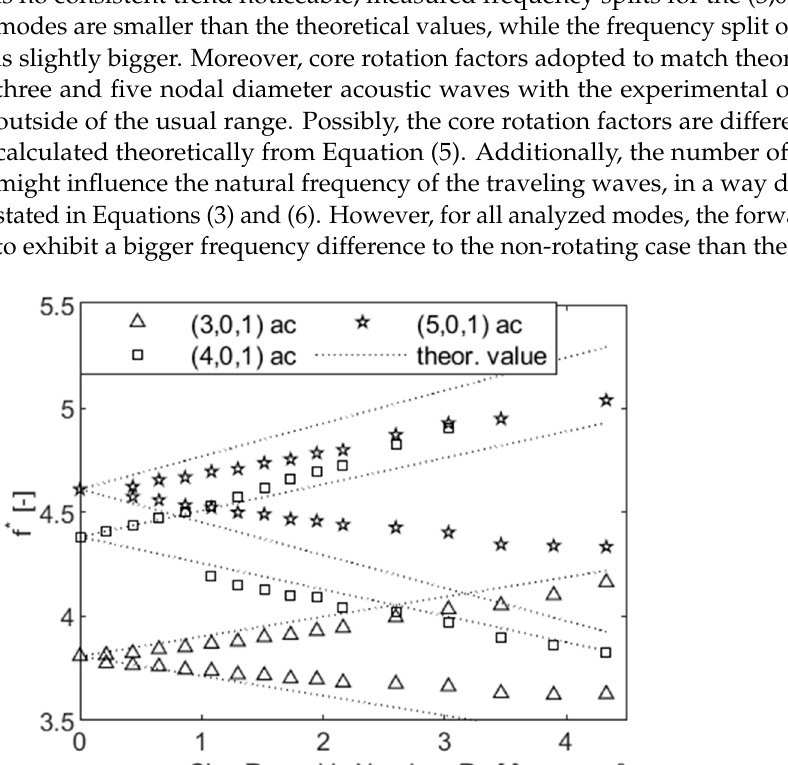
Figure 8. Normalized natural frequencies of structure dominant modes in air at 0.1MPa for “slim cavity” over circumferential Reynolds number. Experimental and theoretical results.